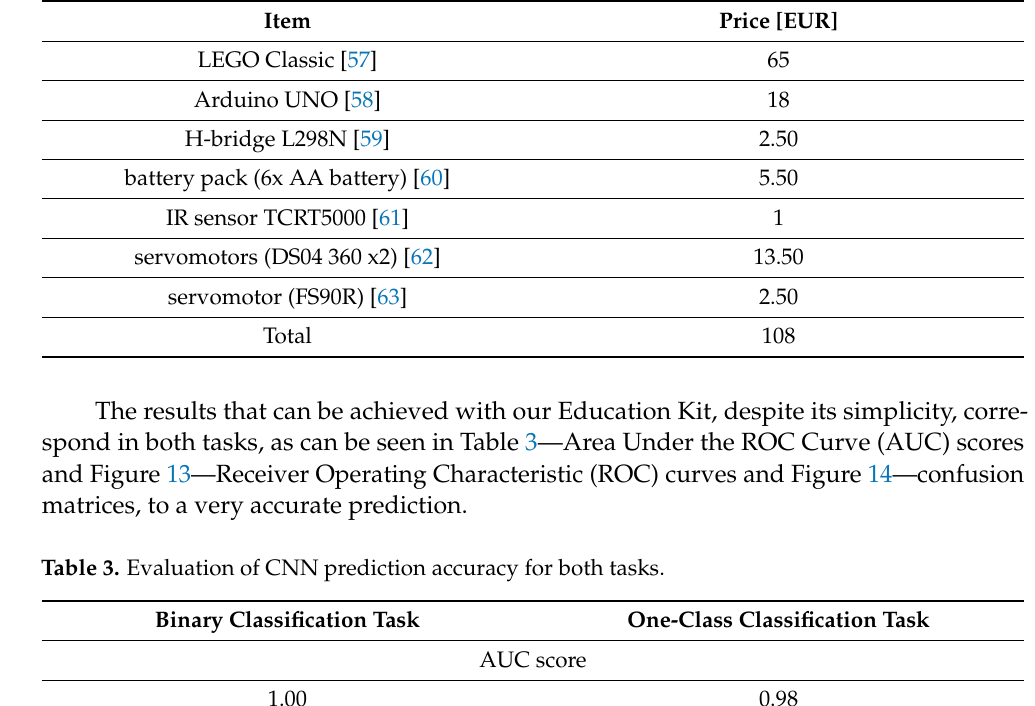
Table 2. Cost of creating the Education Kit (not including the cost of the computer and mobile phone).